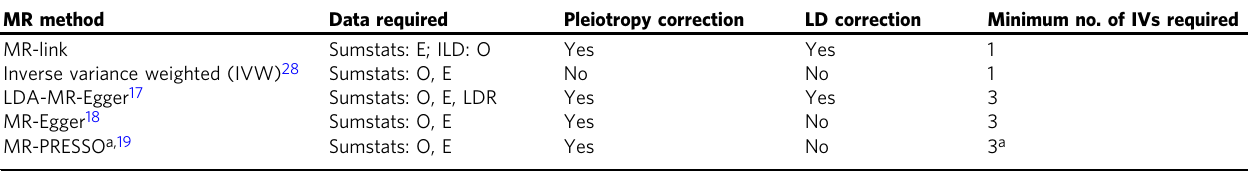
Table 1 MR methods assessed in this study.